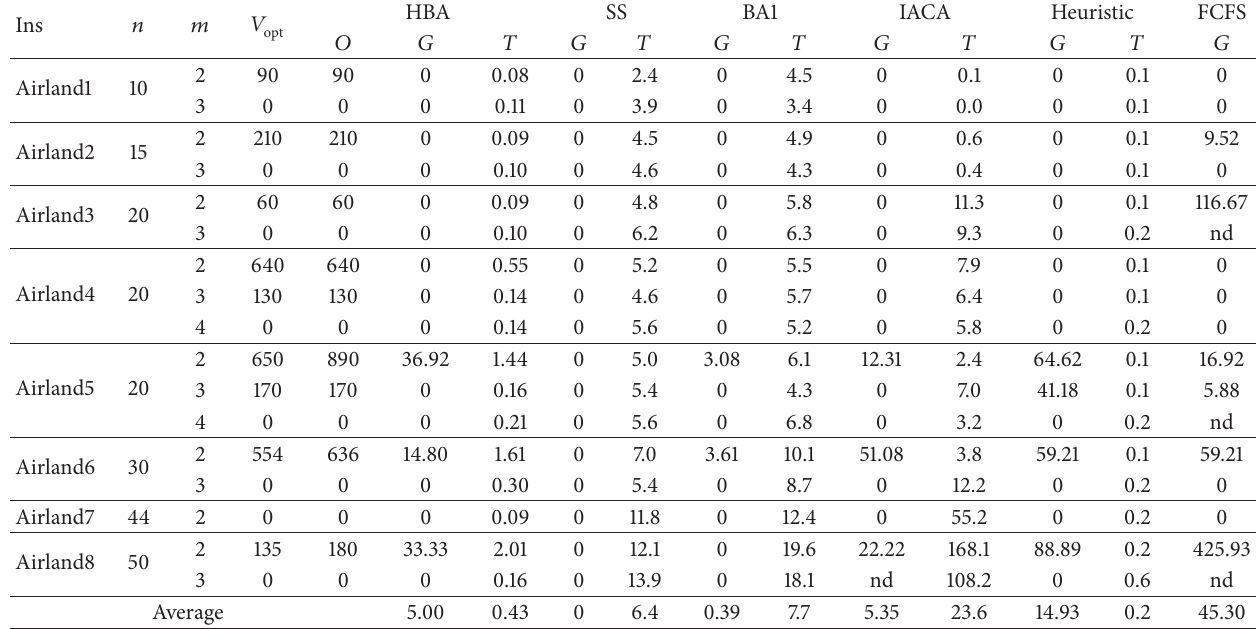
Table 1: The comparisons of computational results for first group instances.